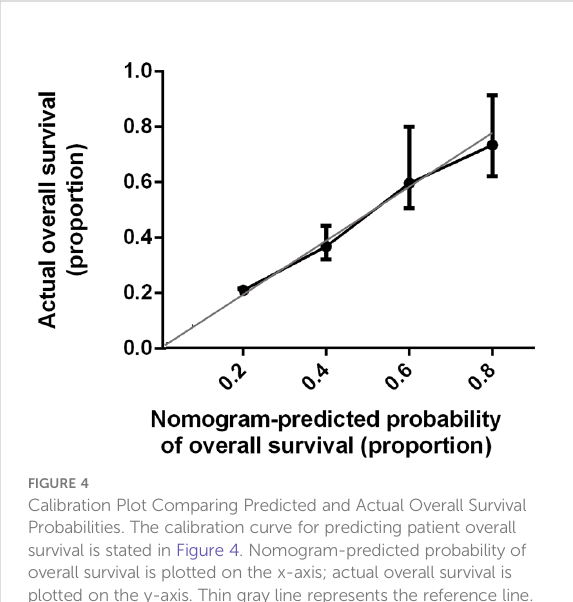
FIGURE 3 Calibration Plot Comparing Predicted and Actual Progression- free Survival Probabilities. The calibration curve for predicting patient progression-free survival is stated in Figure 3. Nomogram-predicted probability of progression-free survival is plotted on the x-axis; actual progression-free survival is plotted on the y-axis. Thin gray line represents the reference line.